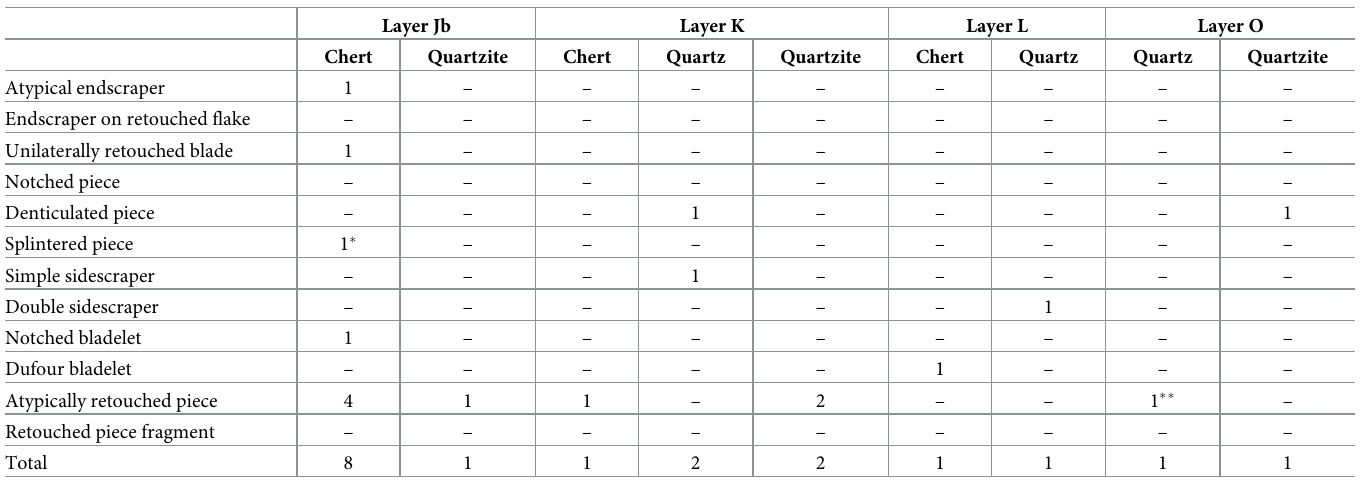
Table 3. Back chamber lithic typology (layers